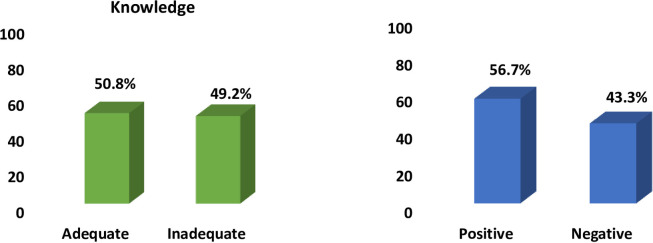
Knowledge and attitude of healthcare waste.